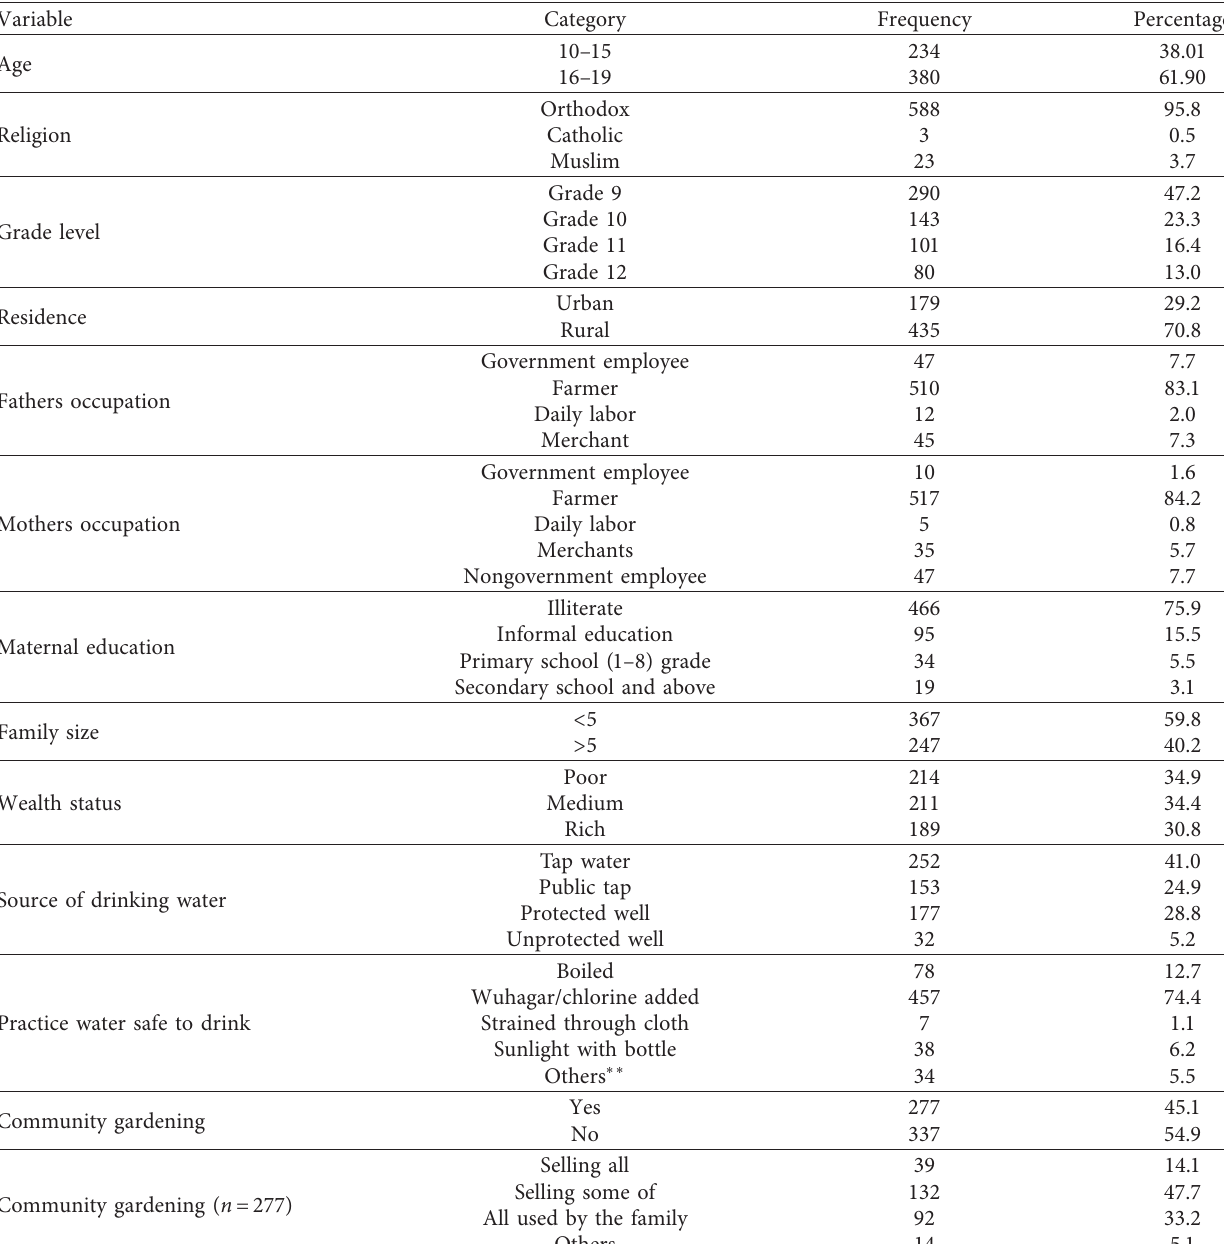
Table 1: Sociodemographic and environmental-related characteristics of adolescent girls in Tach Armachiho district, 2018 ( N � 614).